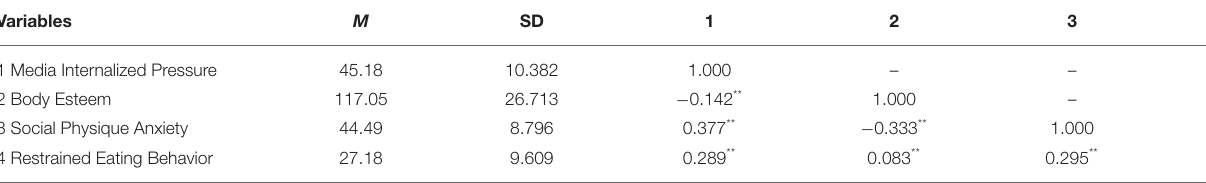
TABLE 2 | Descriptive statistics and correlation analysis for each variable ( n = 1,032). Variables